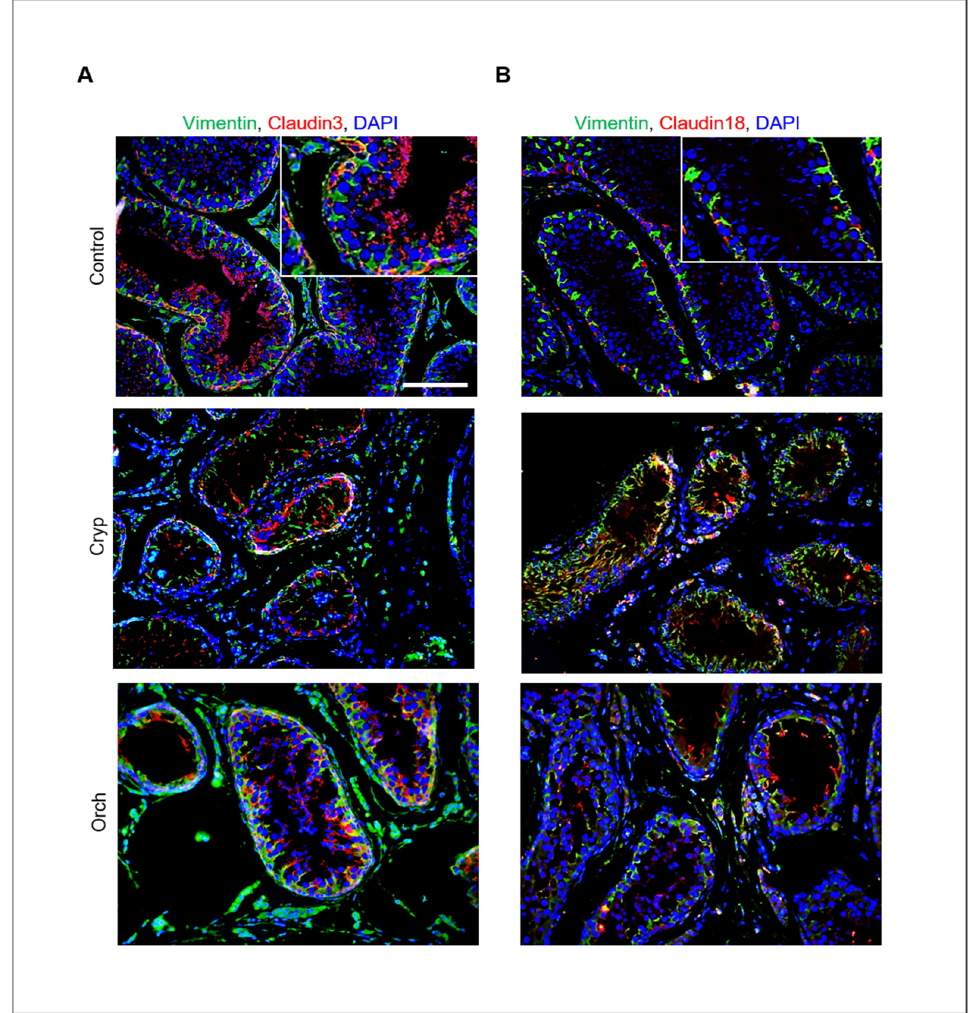
Figure 7. Relative expression of claudins 3 and 18 in wild-type, cryptorchid, and orchiopexied dog testes. ( A ) Vimentin and claudin-3. ( B ) Vimentin and claudin-18 were detected in wild-type, cryptorchid, and orchiopexied dog testes by immunostaining analysis. Vimentin, claudin-3, and claudin-18 were localized in the cell membrane near the basement membrane of the testes. Scale bars = 50 μ m; n = 3, two pairs of testes.